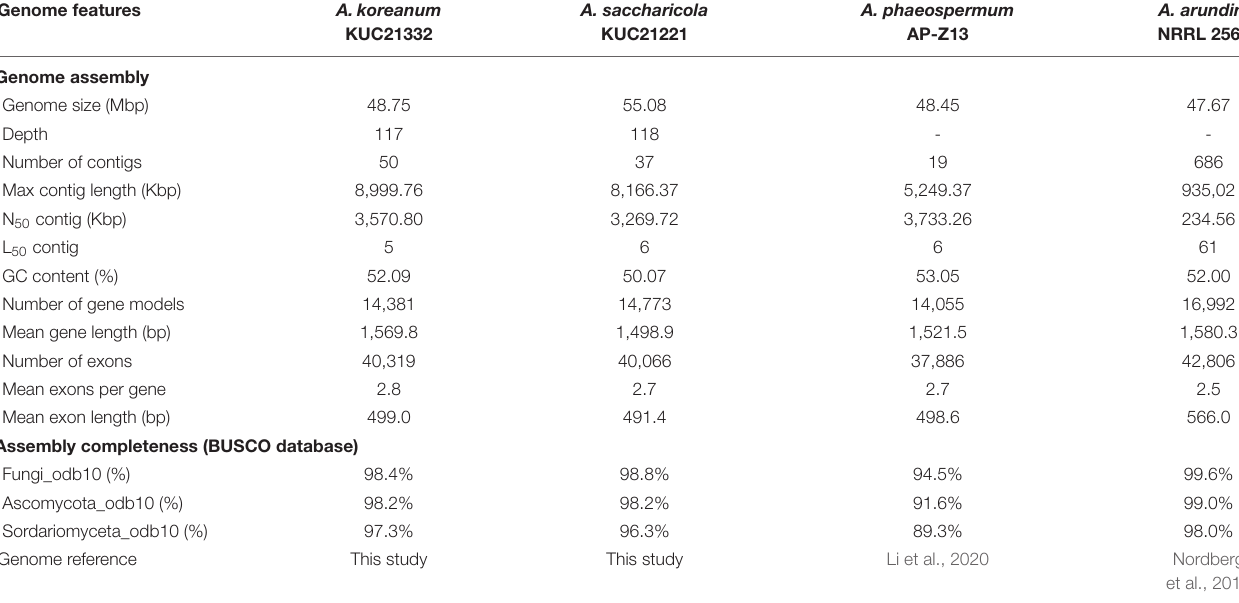
TABLE 1 | Assembly and genome features of Arthrinium koreanum KUC21332 and A. saccharicola KUC21332. Genome